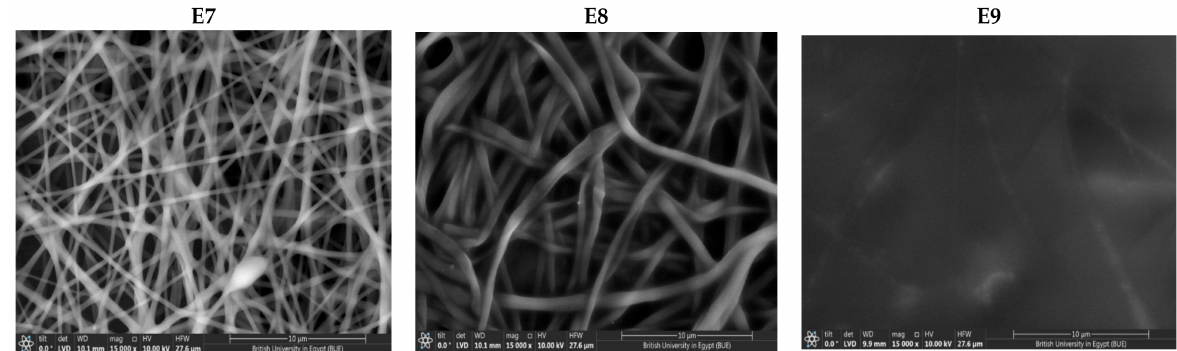
Figure 1. SEM of NFs formulae ( E1 – E9